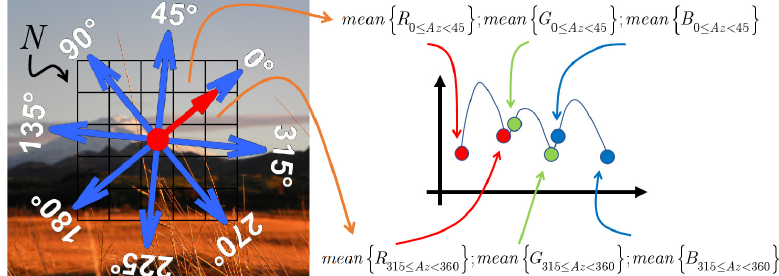
Figure 2. A conceptual illustration of the calculation of rotation-invariant spatial features for learning (RISFL) for a case of N with a size of 5 × 5 and eight directional regions, i.e., n = 8. The red arrow shows the direction of the local gradient, which we use for rotating the local coordinate system. The use of local gradients for this purpose helps in achieving rotation-invariant features.